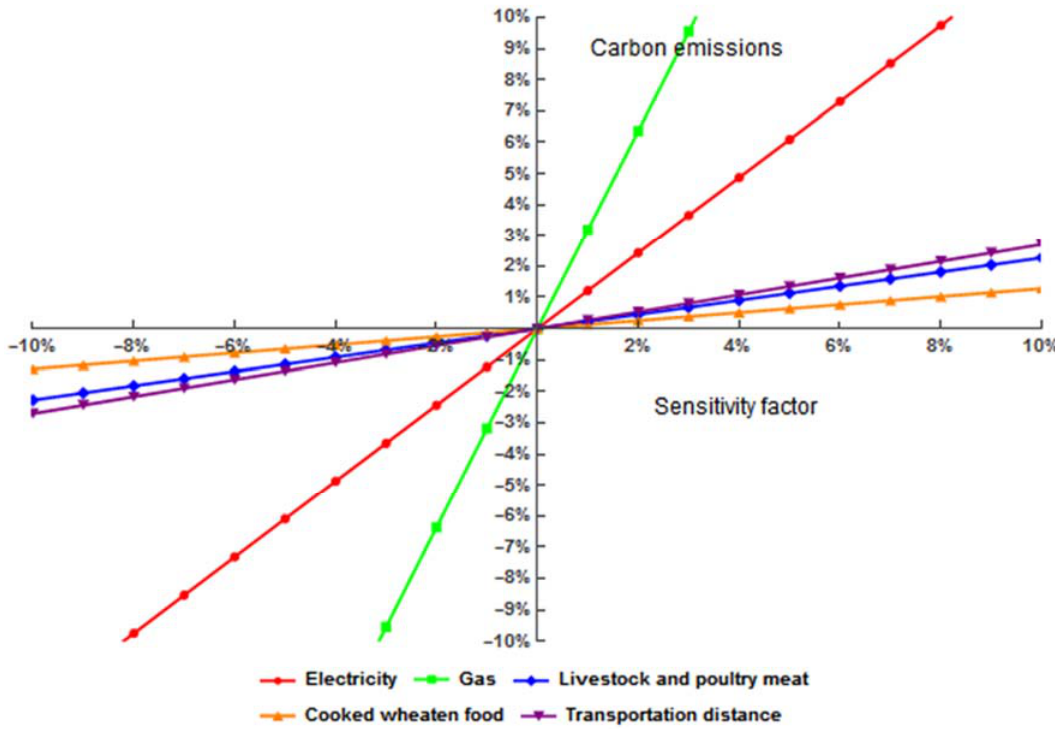
Figure 4. Sensitivity of carbon emissions (per functional unit) to changes in uncertain variables.